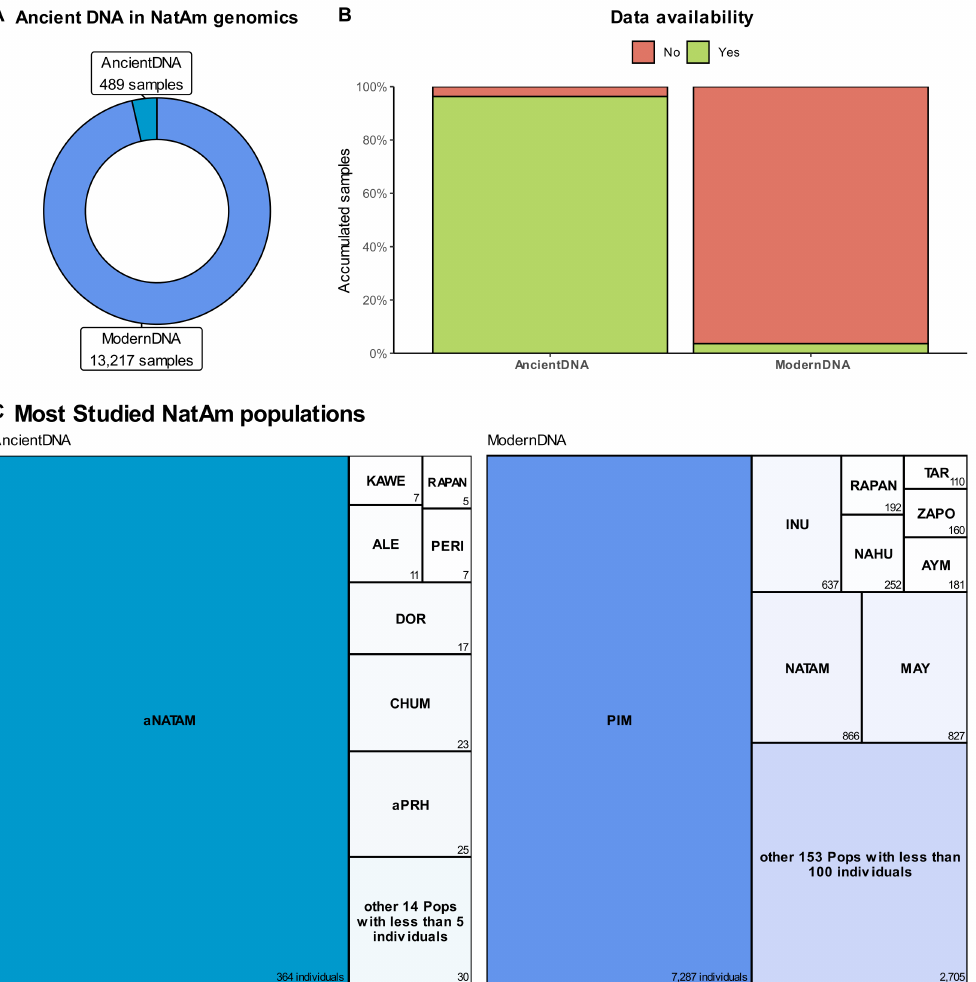
Figure 3. Overview of published NatAm genomic samples. ( A , B ) Ancient samples are a minimal fraction of the total NatAm genomic samples, yet they are mostly available, in contrast with contem- porary samples. ( C ) Some NatAm groups have been thoroughly studied; Pima (PIM), Maya (MAY), and Inuit (INU) are some of the most studied contemporary groups, while Chumash (CHUM), Dorset (DOR), and Aleutian (ALE) are among the most represented in ancient datasets. The homologated codes and full name of the groups can be found in Supplementary Table